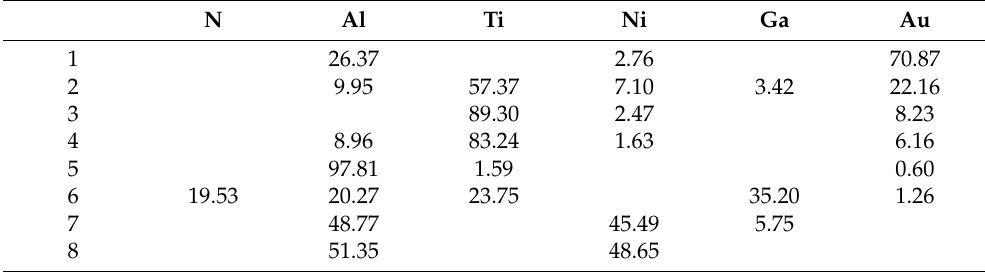
Table 4. EDS Composition (at. %) from the points labeled in Figure 12. Reprinted with permission from Ref. [88]. Copyright 2015, IEEE.